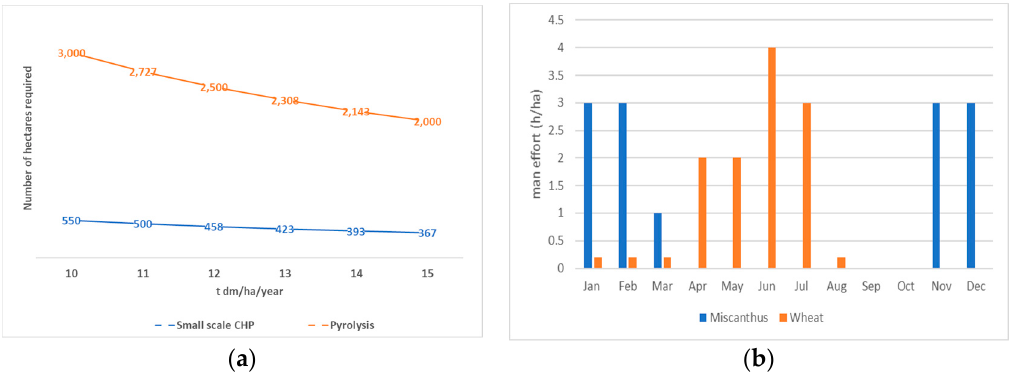
Figure 3. ( a ) Area (in ha) required for crop cultivation per value chain and crop yielding capacity and ( b ) on-farm monthly labour requirements (in man hours/ha) for maintaining and harvesting the crop on an annual basis (excludes establishment).